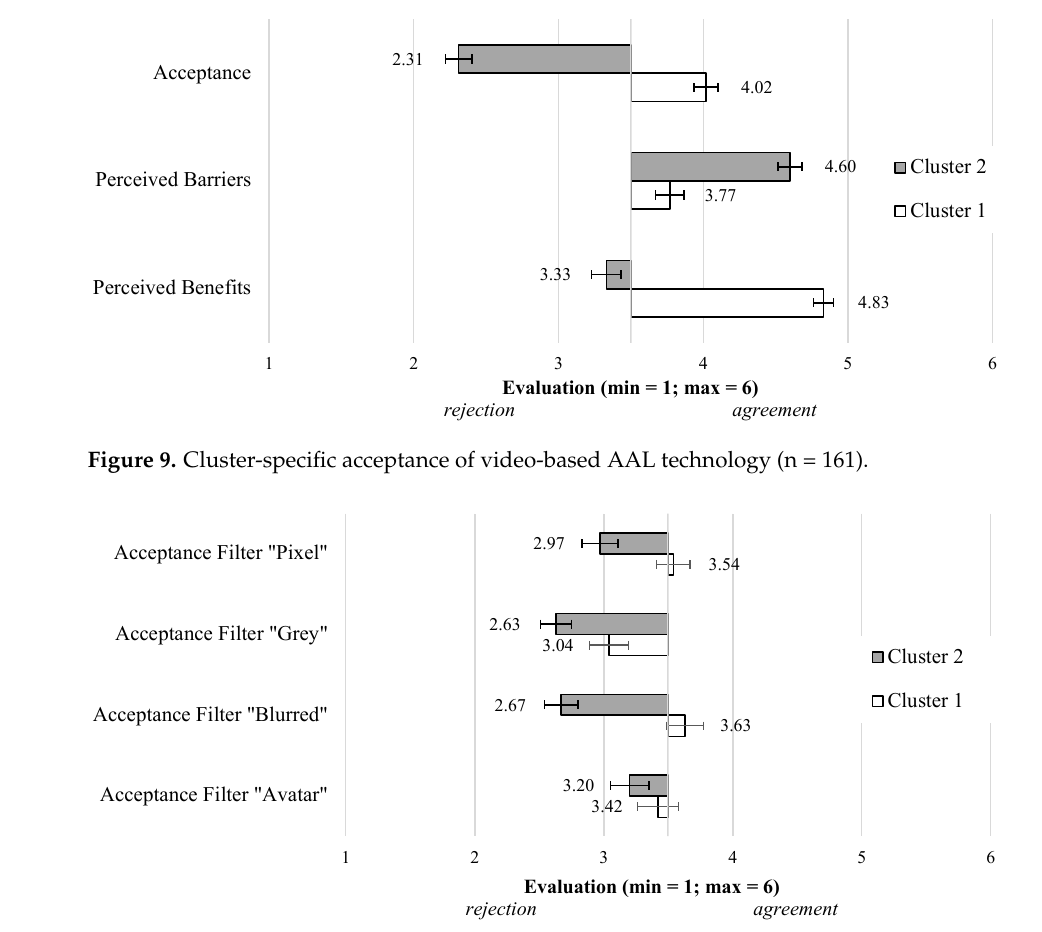
Figure 10. Acceptance of visualization modes depending on the identified clusters (n =